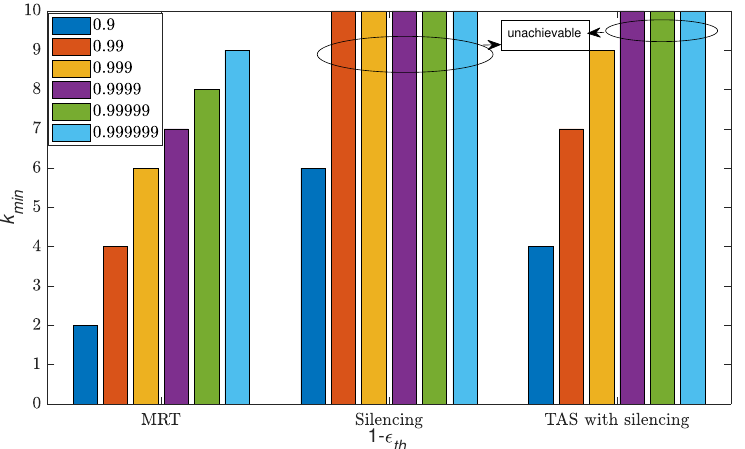
Figure 9. Overview of reliability levels achievable with different number of cooperating RRHs k for silencing, TAS with silencing and MRT schemes with the N = 10.